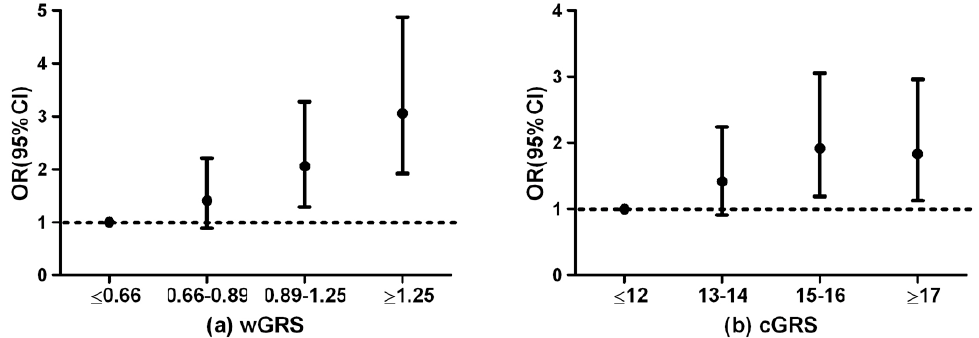
Figure 1. Odds ratio (OR) of T2DM according to the wGRS ( a ) and cGRS ( b ).